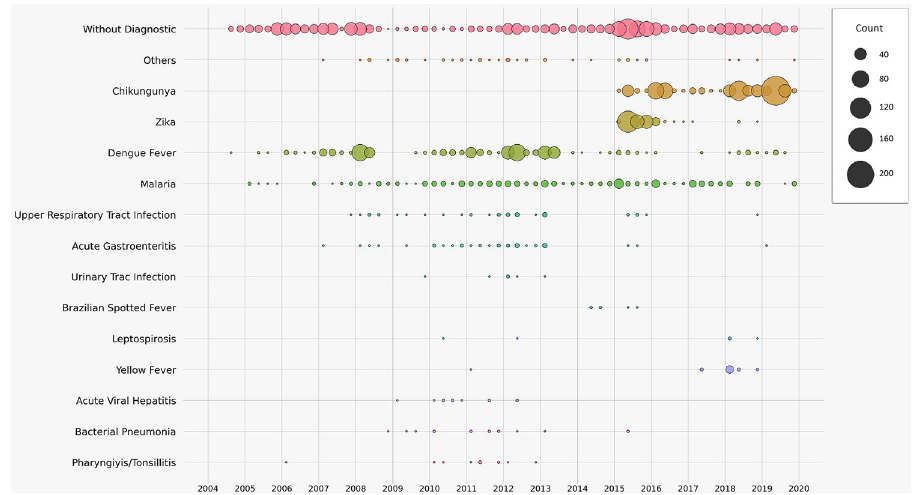
Fig 2. Etiologic diagnosis of the Acute Febrile Illnesses (AFI) over time, between August 2004 and December 2019 (N = 3591).